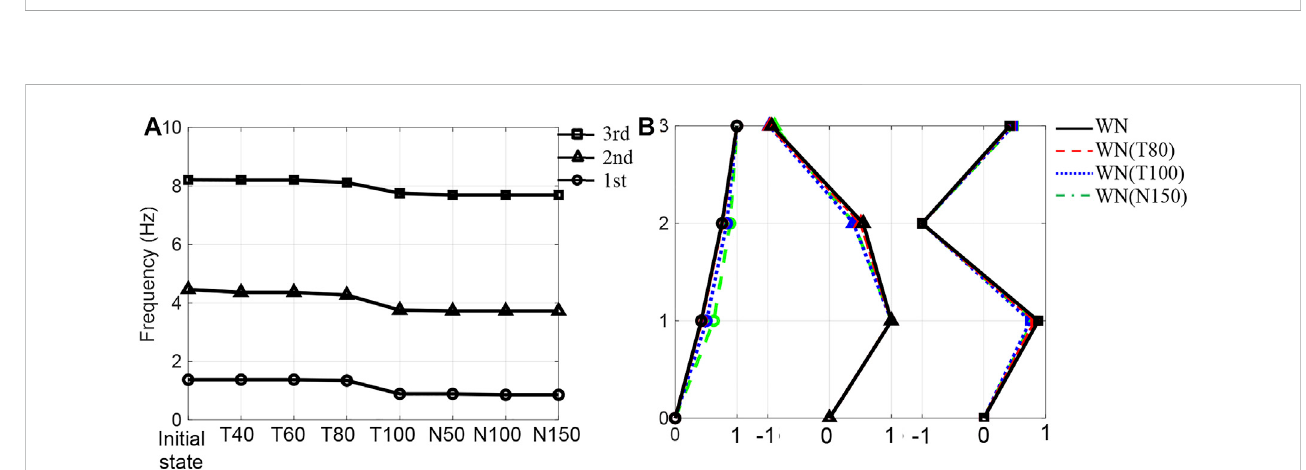
FIGURE 11 Modal parameters obtained by system identi fi cation tests after seismic excitations: (A) natural frequencies and (B) Mode shapes identi fi ed by a band- limited white noise excitation. Note that WN(T100) is the test using the band limited white noise performed after the seismic excitation of 100%